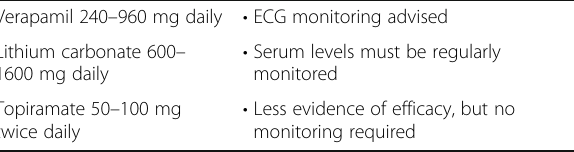
Table 15 Drugs used by specialists in maintenance prophylaxis of cluster